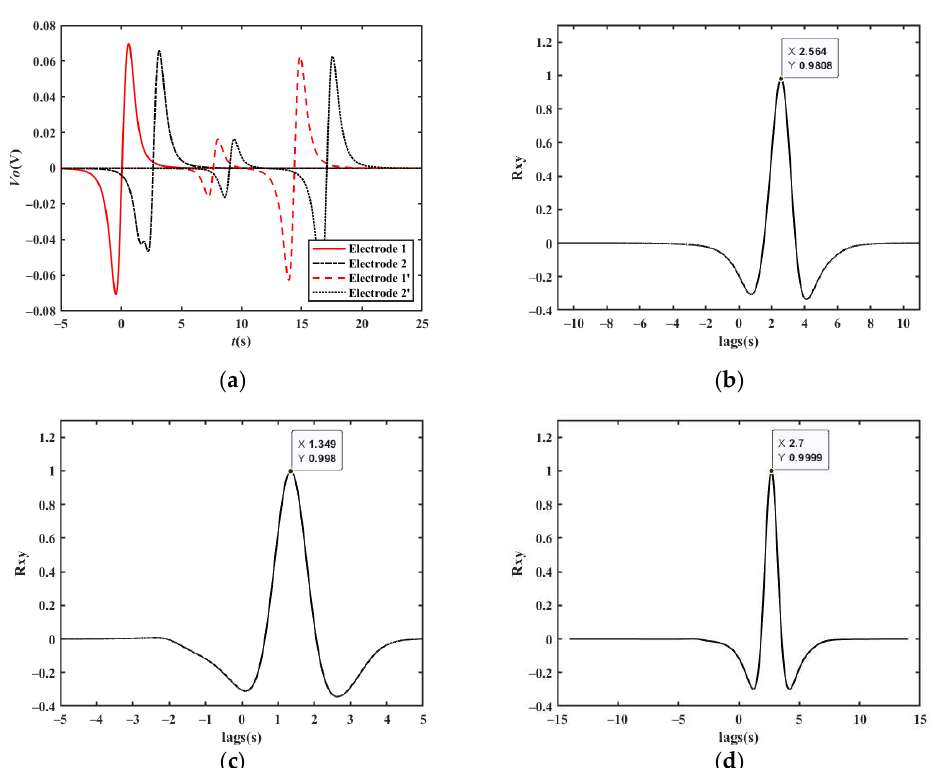
Figure 18. Simulation results of two vehicles driving in two lanes: ( a ) simulation results; ( b ) cross-correlation results of the first group of electrodes; ( c ) cross-correlation results of the second group of electrodes (vehicle 2); ( d ) cross-correlation results of the second group of electrodes (vehicle 3).